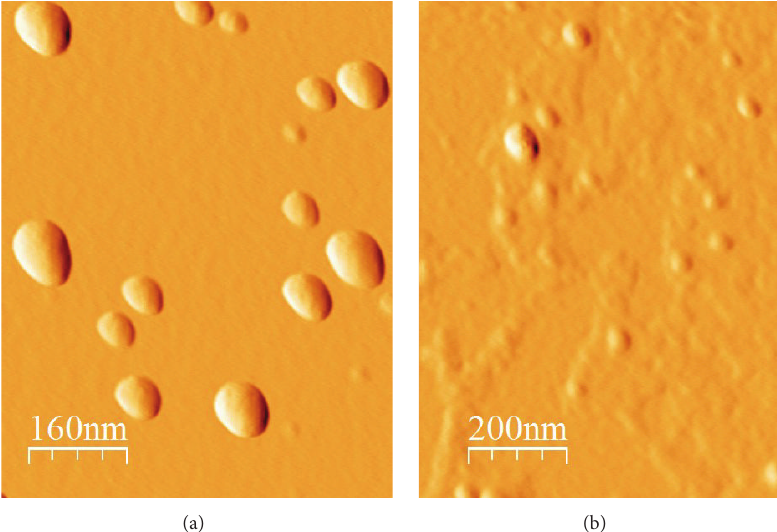
)] 1 -EGDMA 10 , (b) [polyNIPAAm- b -polyHA] 1 - %